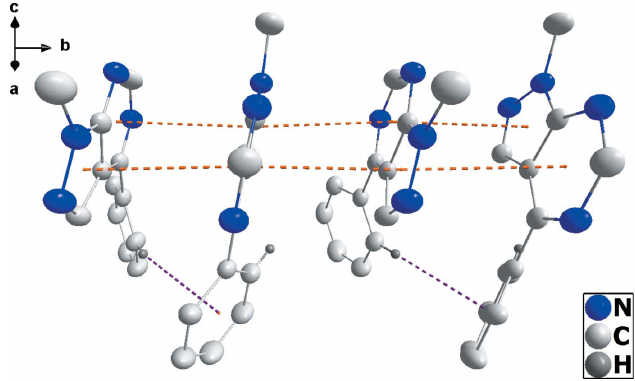
Figure 2 Detail of the (cid:2) – (cid:2) stacking (orange dotted lines) and the C—H (cid:4)(cid:4)(cid:4) (cid:2) (ring) (purple dotted lines) interactions forming stacks along the b direction. H atoms not involved in the interactions have been omitted for clarity.